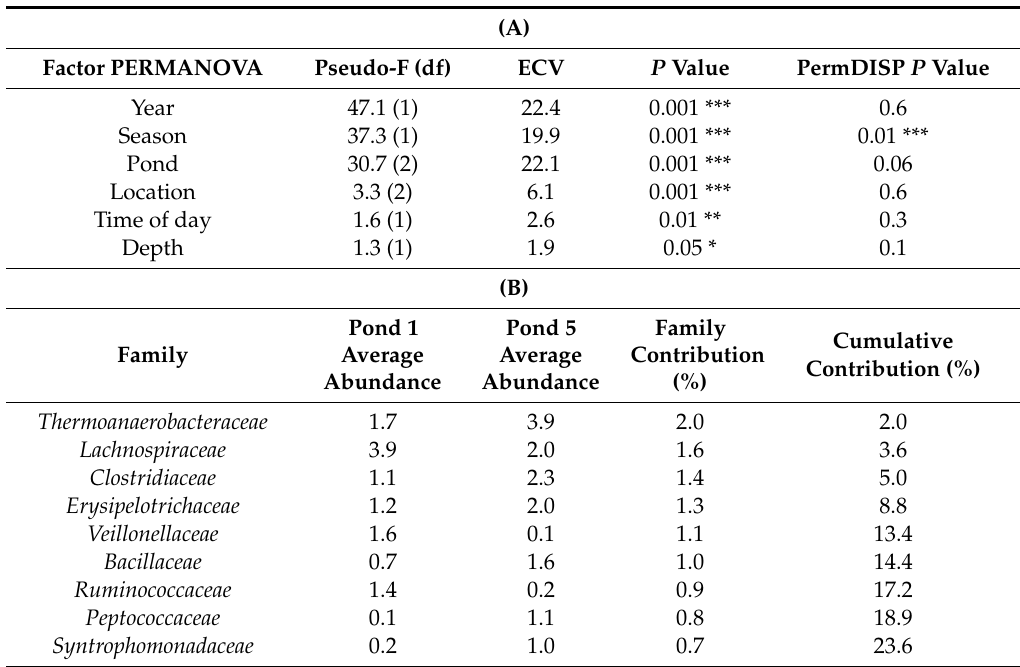
5 = 82.0%. Bray-Curtis similarity cut o ff = 50%.